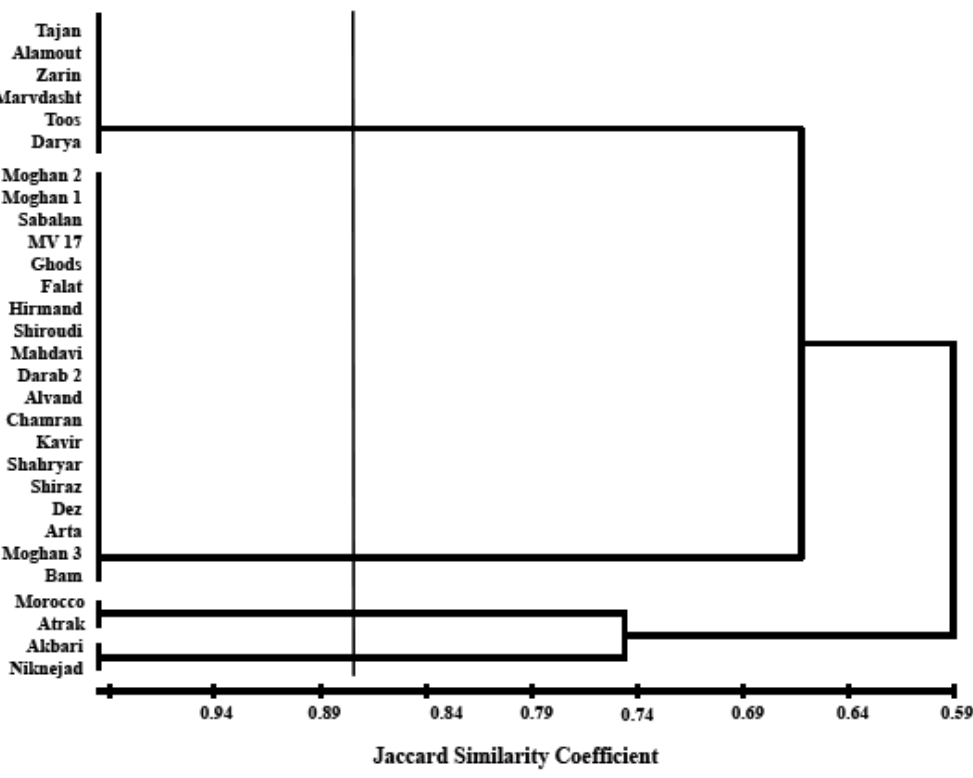
Figure 1. Dendrogram of 29 Iranian wheat varieties based on UPGMA cluster analysis and the Jaccard similarity coef- ficients calculated from evaluation of seedling resistance against four physiological races of Puccinia graminis f. sp.